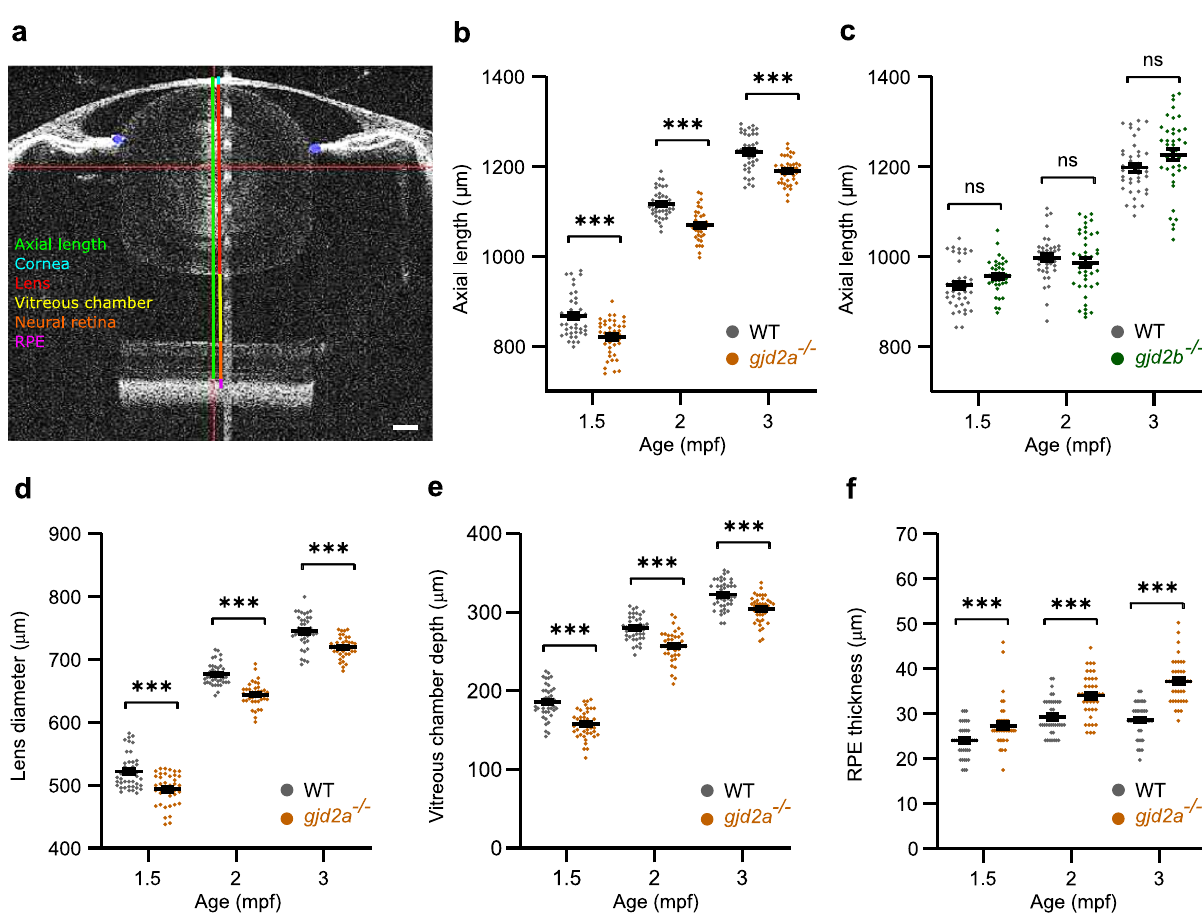
Fig. 1 Loss of Cx35.5 ( gjd2a ) leads to reduced ocular dimensions. SD-OCT recordings of size-matched juvenile-to-adult zebra fi sh indicating the temporal dynamics of the eye. All ocular metrics were corrected for the tissue-speci fi c refractive index. a Single B-scan image of a 3 mpf zebra fi sh eye. The area is de fi ned as the axial length that spans from the apical part of the corneal epithelium to the anterior border of the RPE (green line). The RPE is represented by the hyperre fl ective melanin-rich band (magenta), of which the anterior part comprises a sharp-cut border, used as a posterior landmark for the axial length. The gradient refractive index of the spherical zebra fi sh lens was used as a correction factor to acquire this image (see “ Methods ” ), and the brightness was enhanced for better visualization of the transparent lens. Individual compartments: cornea (light blue), lens (red), vitreous chamber (yellow), neural retina (orange). b , c Axial length of gjd2a (Cx35.5) ( b ) and gjd2b (Cx35.1) ( c ) mutant eyes of juvenile (1.5 – 2 mpf) and adult zebra fi sh (3 mpf). b The gjd2a (Cx35.5) eyes were signi fi cant reduced in axial length compared with WT at 1.5 mpf (effect size = − 47 µ m, p < 0.001), 2 mpf (Effect size = − 48 µ m, p < 0.001), and 3 mpf (effect size = − 43 µ m, p < 0.001). c The gjd2b (Cx35.1) mutant eyes showed no signi fi cant alteration relative to WT. d , e , f Dimensions of signi fi cantly altered ocular compartments in gjd2a (Cx35.5) mutant eyes. See Supplementary Data S1 and S2 for a full statistical report and dimensions of individual compartments. Sample size: n = 40 eyes for each genotype and time point. Error bars: SEM. Signi fi cance: ns = not signi fi cant, * p < 0.05, ** p < 0.01, *** p < 0.001. Scale bar: 100 µ m. Mpf months post-fertilization, SD-OCT spectral-domain optical coherence tomography, RPE retina pigmented